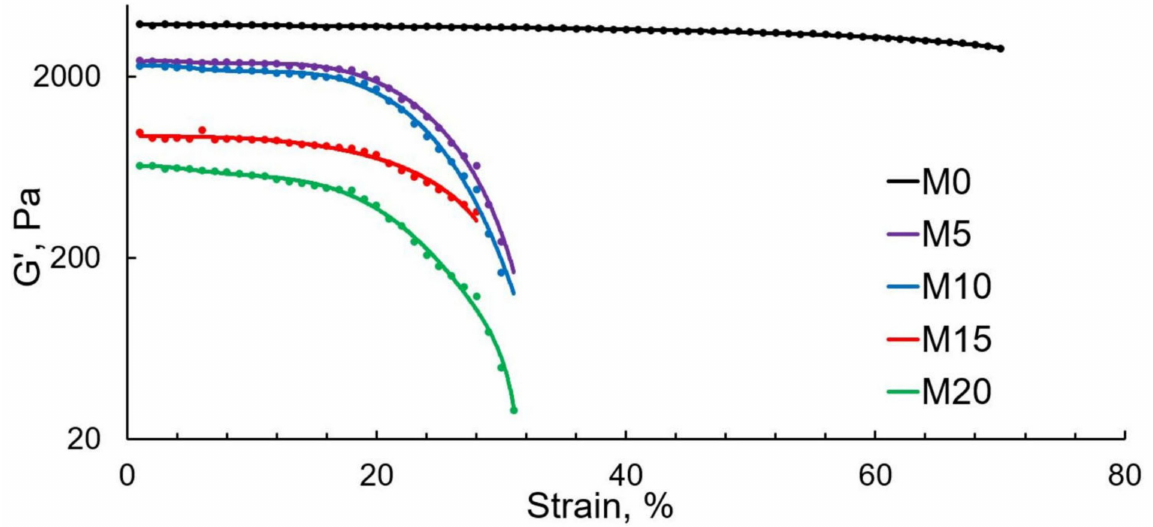
Figure 6. Correlation between G’ and